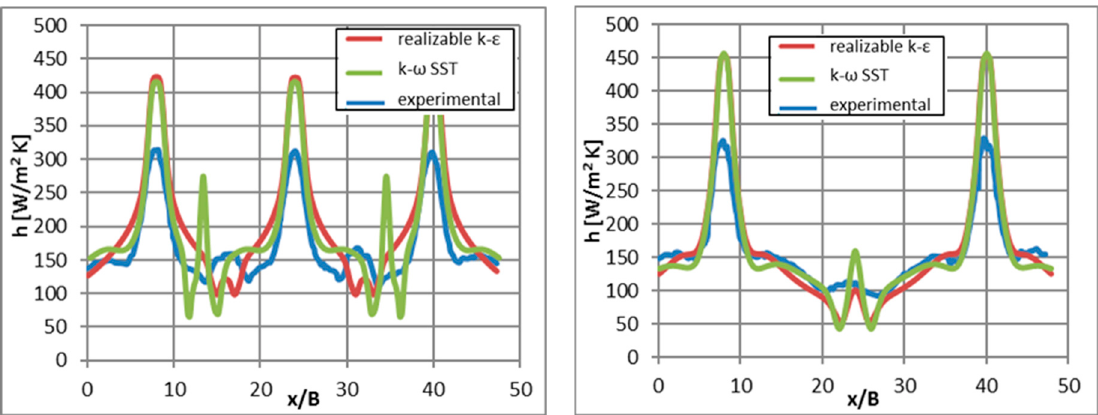
Figure 15. Comparison between numerical and experimental data of the convective heat transfer coefficients for the multi slot configurations with H/B = 4 and Re = 5500: 3 slots ( left ) and 2 slots ( right ).